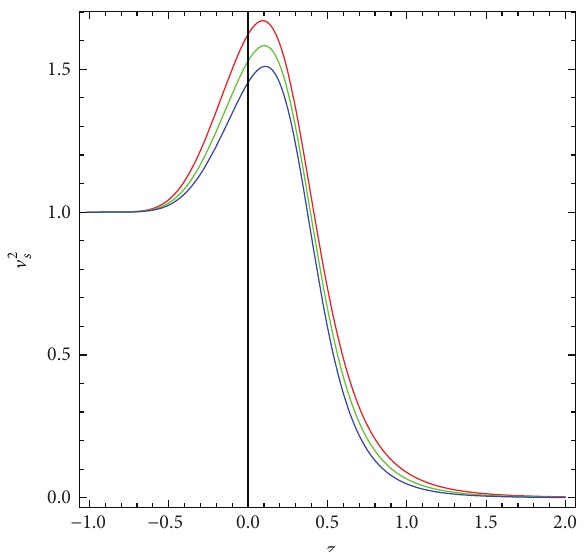
Figure 5: Plot of V 2 𝑠 versus 𝑧 for PDE parameter 𝑢 = 2 with 𝑚 = 2 (red), 𝑚 = 2.2 (green), and 𝑚 = 2.4 (blue).